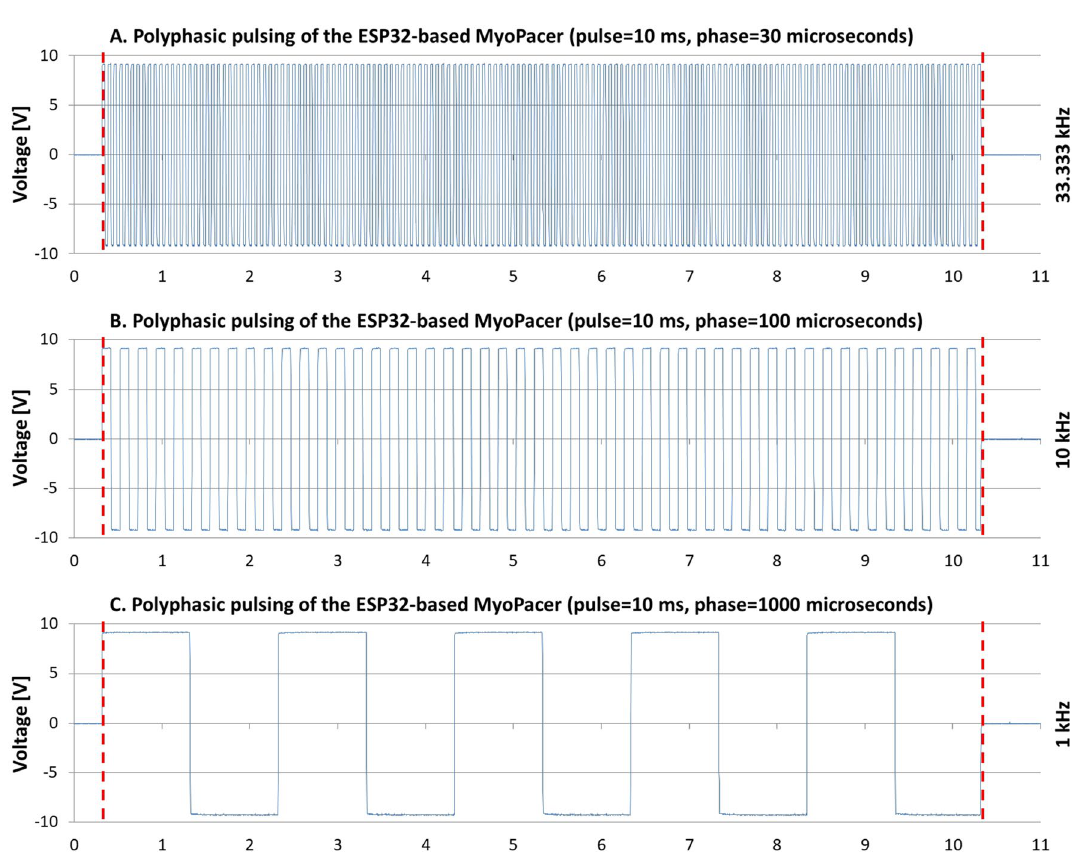
Figure 6. Polyphasic pulsing of the ESP32-based MyoPulser. This figure depicts a 10 ms polyphasic pulse (marked by vertical dashed lines) with different phase constants applied. Here, “phase” represents the repolarization time in microseconds (30 in ( A ), 100 in ( B ) and 1000 in ( C )). On the right side of each panel, the according alternating current frequency is